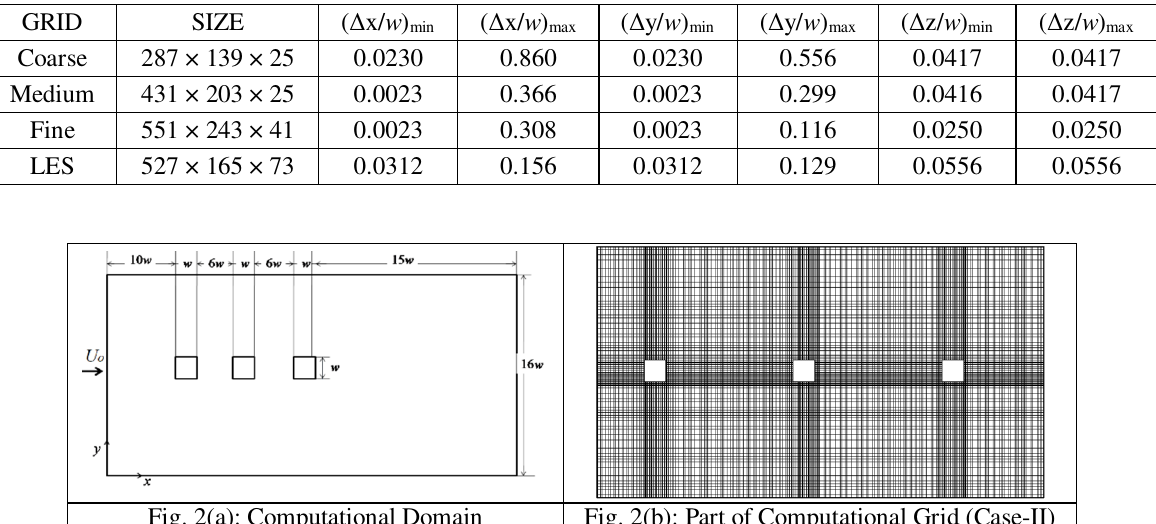
Table 2: Grid Details for Tandem Square Cylinders (Case-II)